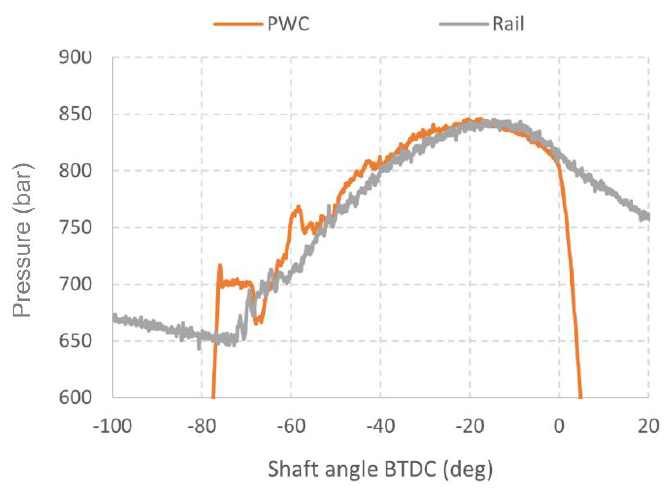
Figure 7. PWC and rail pressure trends–Low pressure, 1500 RPM, D100.